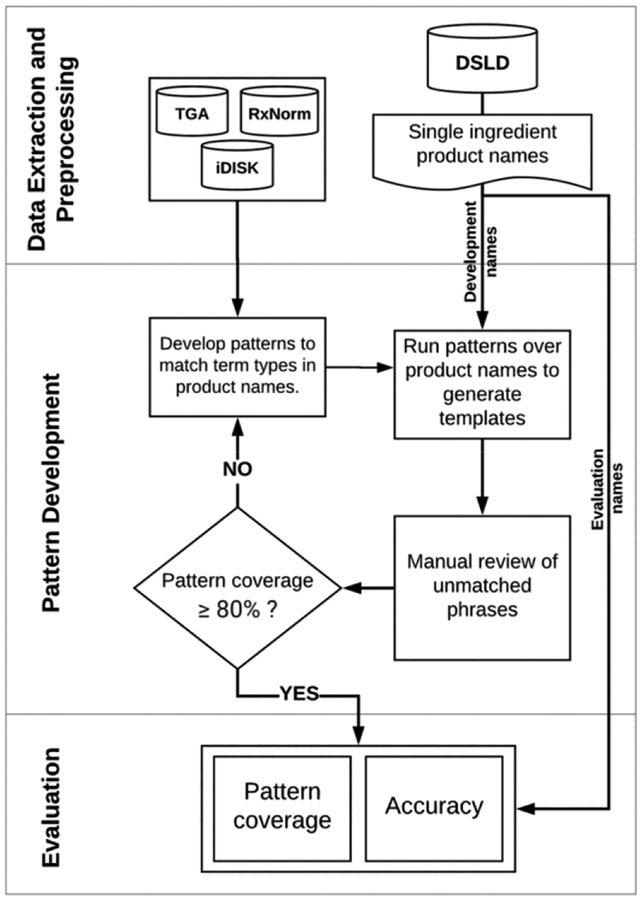
The study design.